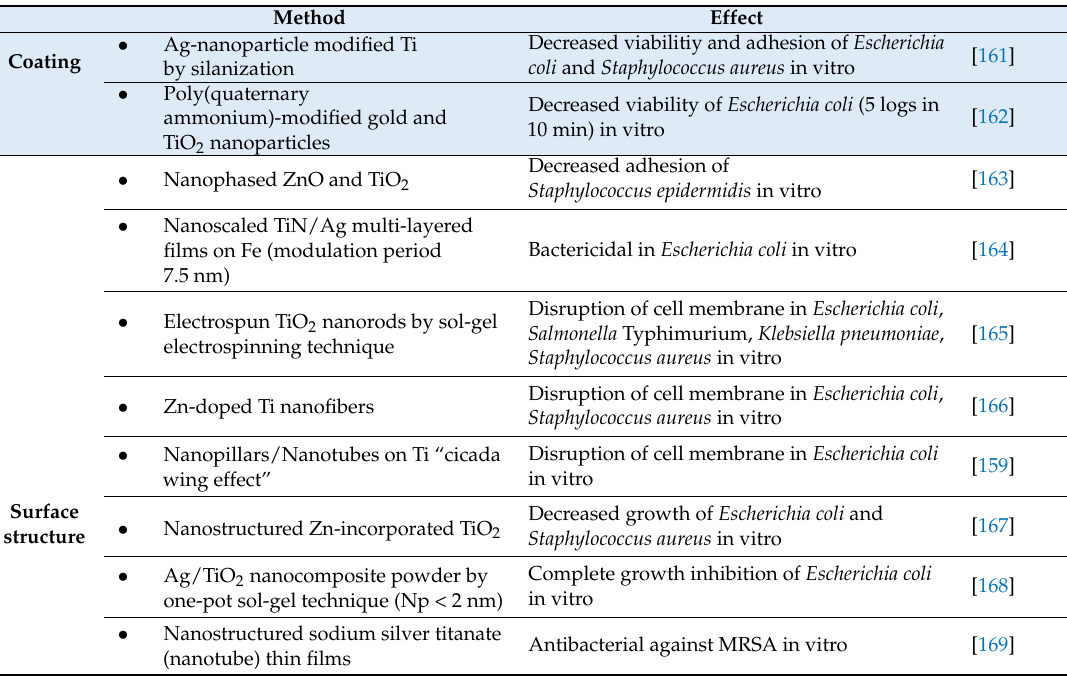
Table 3. Nanostructured antibacterial titanium surfaces (Ag: silver, Zn: zinc, Fe: iron, TiN: